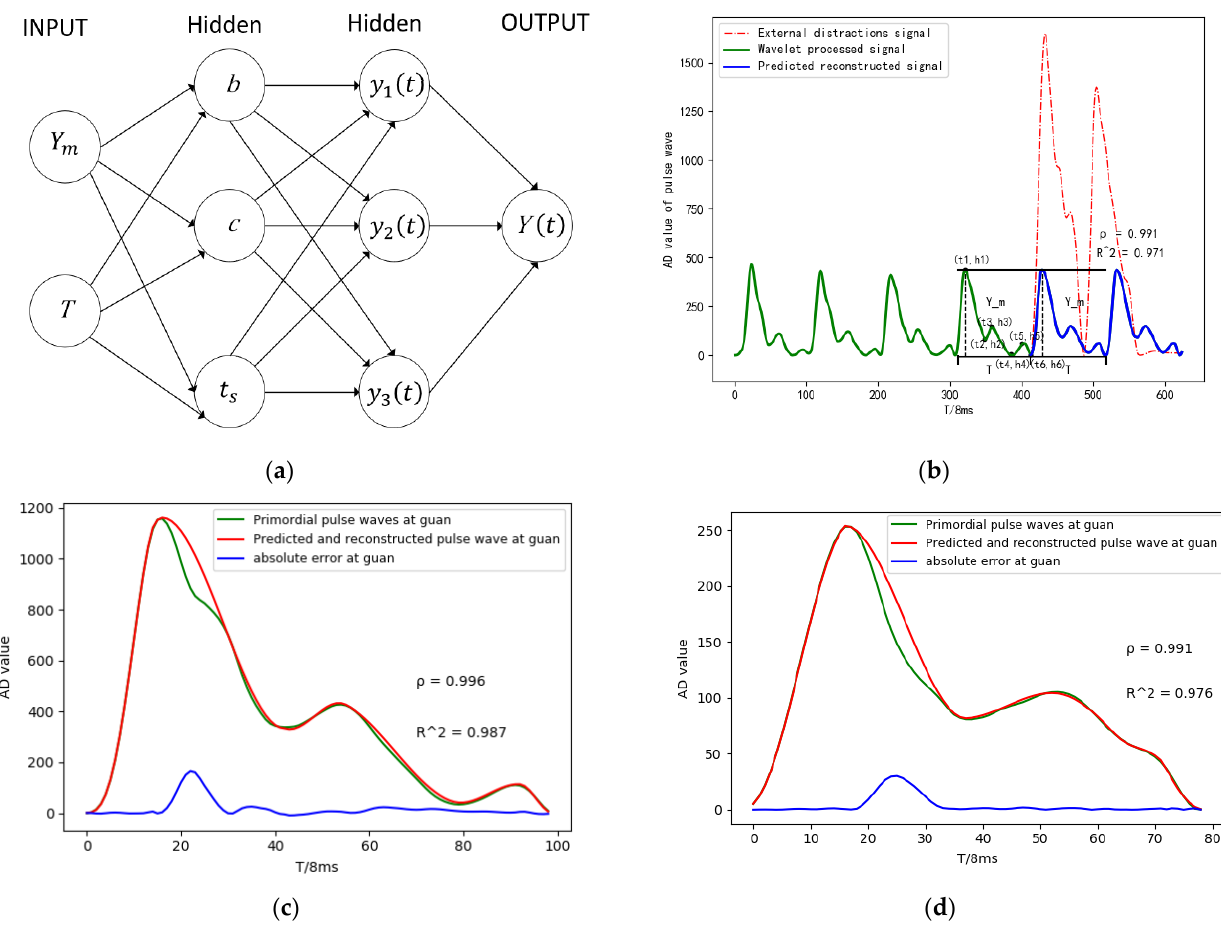
Figure 6. Prediction and reconstruction of the pulse signal: ( a ) neural network structure; ( b ) principles of prediction and reconstruction; ( c ) prediction and reconstruction effects of the normal pulse; and ( d ) prediction and reconstruction effects of the slippery pulse.